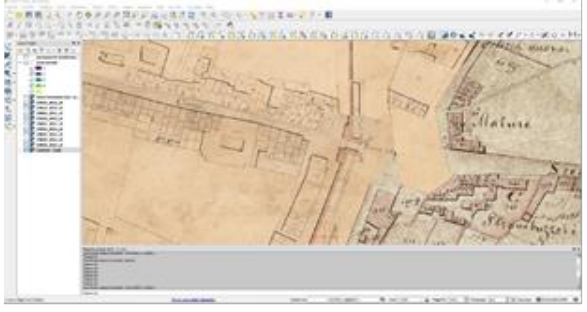
Figure 12. CASTORE map inside the GIS model.